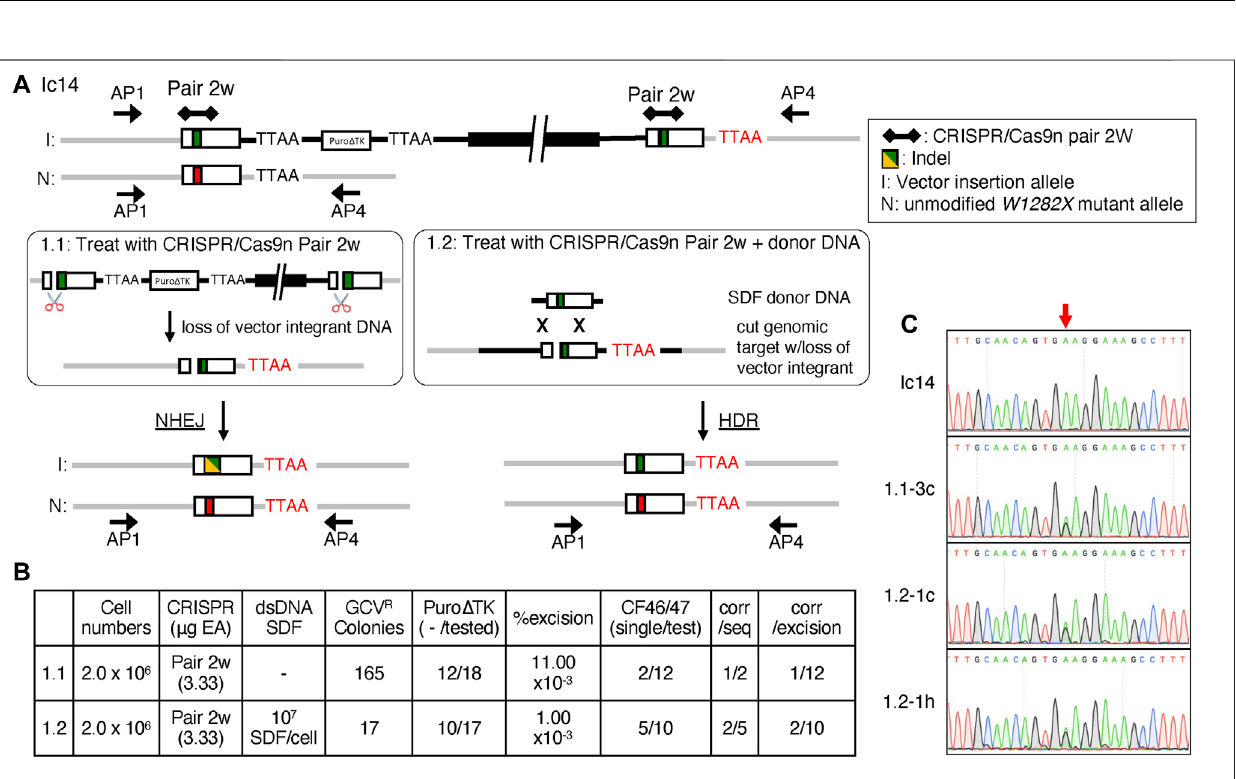
FIGURE 6 | Seamless excision of Vector Insertions by NHEJ and HDR with CRISPR/Cas9n-pair-2w. (A) Strategy of excising inserted backbone in order to obtain seamless corrected CF2-iPS3 cells using CRISPR/Cas9n-pair-2w. Both methods were performed using the CRISPR/Cas9n-pair-2w, but in the presence (treatment 1.2) or absence (treatment 1.1) of a homologous donor SDF. The gRNA targeting site is represented by black diamonds and connected by the line for a pair. Indel is indicated by the yellow/green box, the W1282X -wt allele is indicated by a green box and the W1282X -mutant allele by a red box. I; Vector insertion allele, N; unmodi fi edallele.TheredTTAAsequenceisthepredictednativegenomeTTAAwhereastheblackTTAAwouldbefromthetargetingvector.TheIc14celllineusedhada geneconversioneventintheupstreamalleletogeneratea W128X -wtallelethusbothvectorinsertionalleleswere W1282X -wt. (B) Comparisonoftheseamlessexcision ef fi ciencies in Ic14 clone between treatment 1.2 and 1.1. (C) Sequence histogram of AP1/4 amplicon shows single peak of A in W1282X site in Ic14 (Pre-excision), and mix peak of A and G in Ic14 1.1-3c, 1.2-1c and 1.2-1h (Post-excision). Red arrow points to W1282X mutation site.